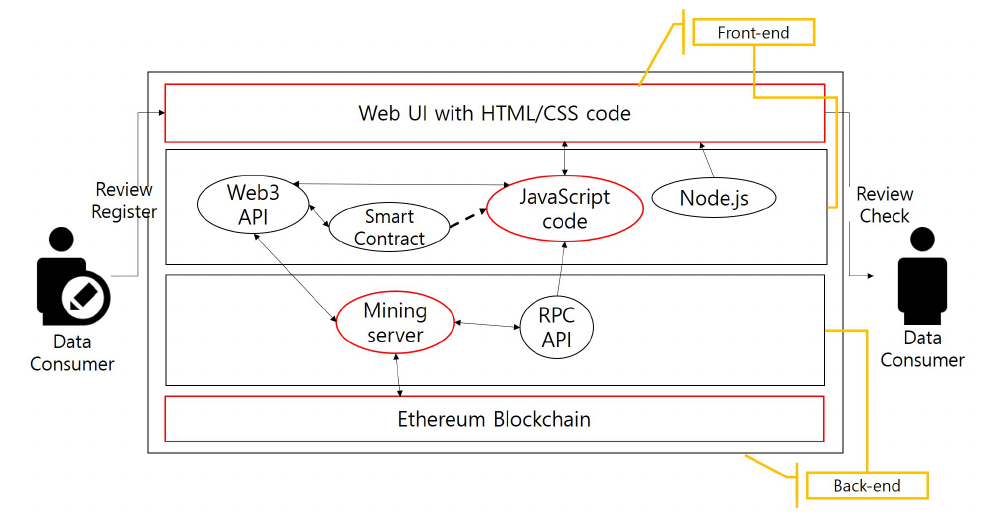
Figure 2. System